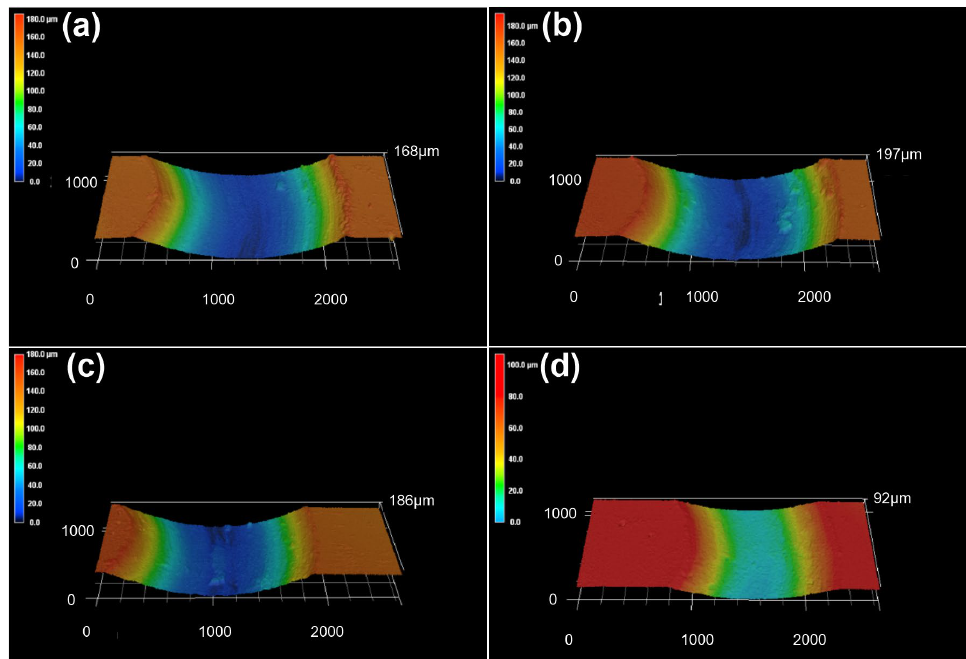
Figure 9. 3D morphologies of the worn surfaces of the ( a ) substrate, ( b ) FeCoCrNi, ( c ) FeCoCrNiAl 0.5 , ( d ) FeCoCrNiAl. ( d )